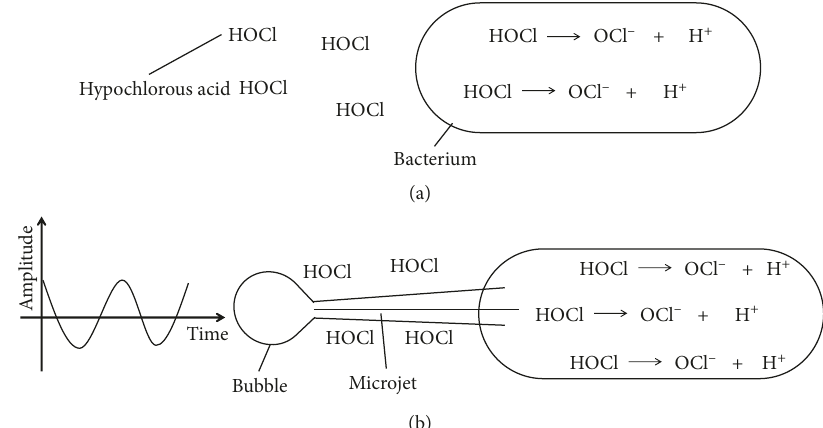
Figure 2: (a) Hypochlorous acid penetrates the bacteria and dissociates. (b) The bubble implosion generated by the cavitation process forms a microjet that impulses hypochlorous acid into the bacterial cell. Therefore, a greater amount of this compound is obtained in the cellular cytoplasm resulting in a greater antibacterial effect of sodium